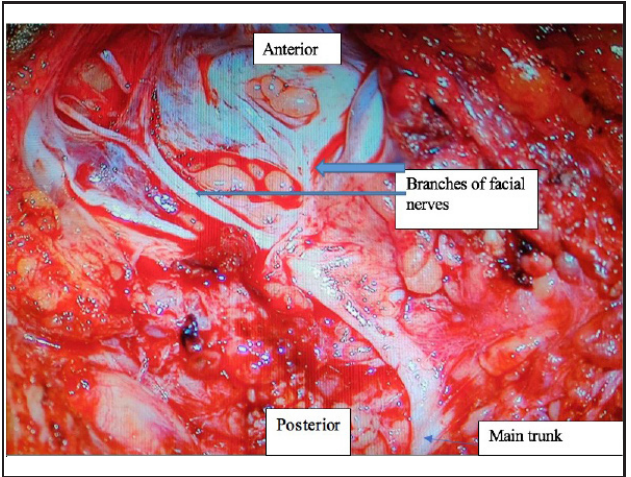
Figure 2. showing intraoperative microscopic view of main trunk and Superior division in parotid lymphangioma Pleomorphic